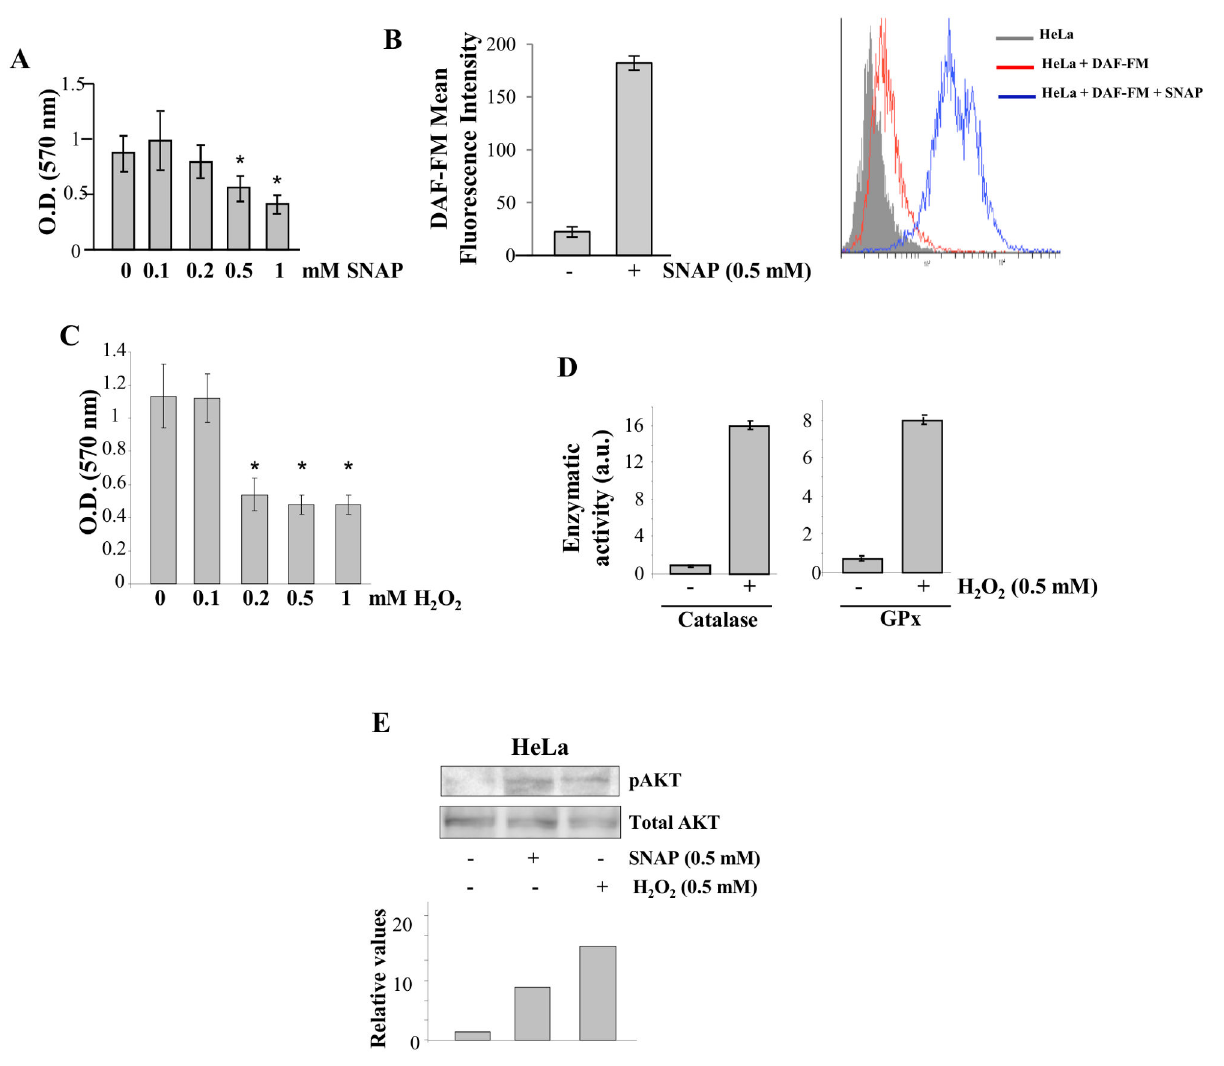
Figure 1. HeLa cells submitted to oxidative and nitrosative stress conditions. ( A ) HeLa cells were treated with increasing concentrations of SNAP (0 - 1.0 mM) during 2 h. After this period medium was replaced for complete medium (MEM supplemented with 10% FBS). Cell viability was determined 24 h later using the MTT assay as described in Materials and Methods. Values are reported in the bar graphs and expressed as means ± S.D. (n = 3, * p < 0.05). ( B ) Intracellular NO detection in HeLa cells after incubation with 0.5 mM SNAP for 2 h at 37°C. DAF fluorescence is directly related to NO generation by intracellular metabolism of SNAP and was determined by flow cytometry. ( C ) HeLa cells were treated with increasing concentrations of H O (0 - 1.0 mM) 2 2 during 2 h. After this period medium was replaced for complete medium (MEM supplemented with 10% FBS). Cell viability was determined 24 h later using the MTT assay as described in Materials and Methods. Values are reported in the bar graphs and expressed as means ± S.D. (n = 3, * p < 0.05). ( D ) Catalase and Glutathione Peroxidase enzymatic activity assays (described in Materials and Methods) were performed after exposure of HeLa cells to 0.5 mM H O for 2 h at 37°C. ( E ) HeLa cells were exposed 2 2 to 0.5 mM SNAP or to 0.5 mM H O for 2 h at 37°C. After cell lysis, 50 μg total protein were subjected to Western blotting with a 2 2 rabbit polyclonal anti-phospho-Akt antibody and with a mouse monoclonal anti-Akt antibody. Western blot results are representative of three independent experiments. Histogram represents the ratio between the densitometric values of the protein bands corresponding to the phosphorylated form of Akt and of Akt protein of one representative experiment (Lower panel).